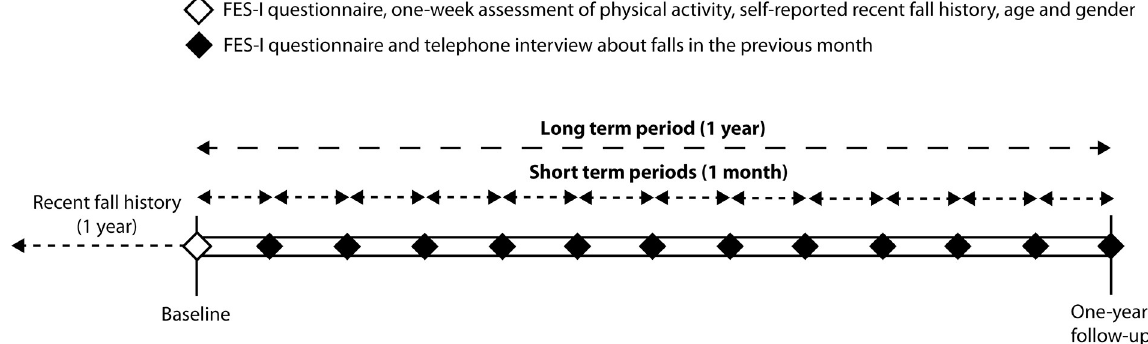
Fig 1. Timeline of study assessments. Short-term and long-term periods are defined to determine whether concern about falling at the start of such a period is predictive for falling within such a period and whether falling within such a period is predictive of having increased concern about falling at the end of that period compared to the start of that period. At baseline, a participant’s first assessment, participants reported any falls they had experienced in the previous year and physical activity during one-week, age and gender were